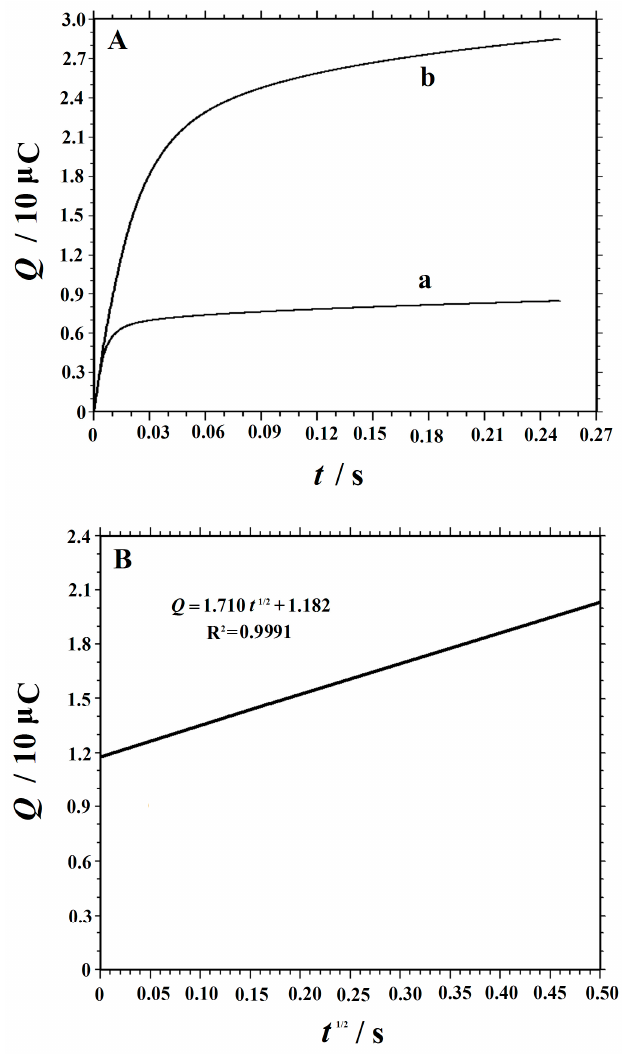
Figure 6. ( A ) Chronocoulometric curves for Cu 2 O-ERGO/GCE in 0.1 M H 2 SO 4 solution in absence of (a) and in present of (b) 0.1 mM vanillin. ( B ) Plot of Q – t 1/2 derived from chronocoulometric curves for Cu 2 O-ERGO/GCE (background subtracted).